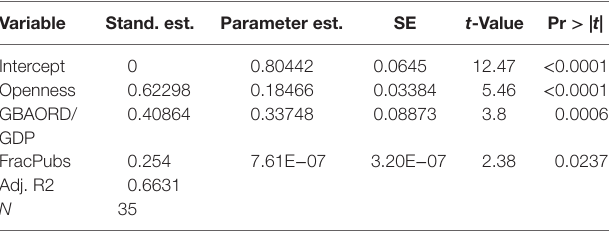
TaBle 3 | Linear regression analysis—dependent variable is impact (fractional field-weighted citation impact). Variable stand.